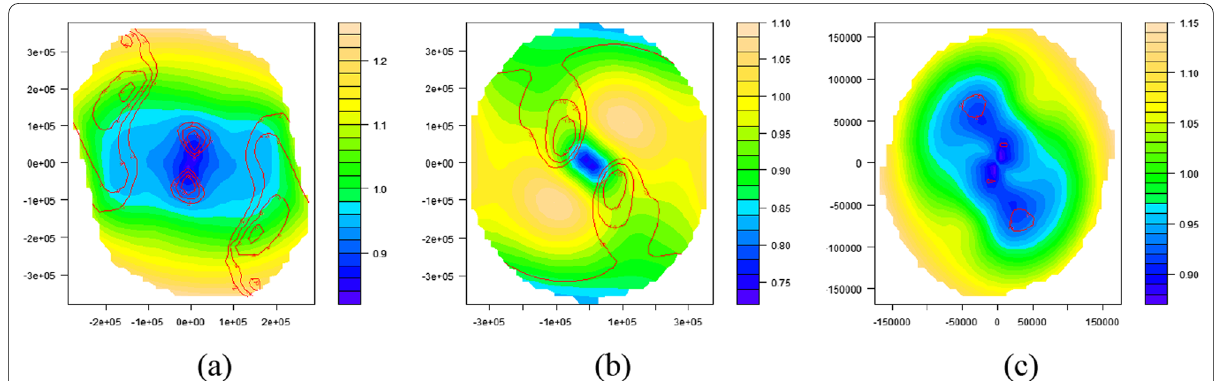
Fig. 9 Smoothed variogram of residuals of PGD at record stations of Chuetsu ( a ), Tottori ( b ), Northridge ( c )